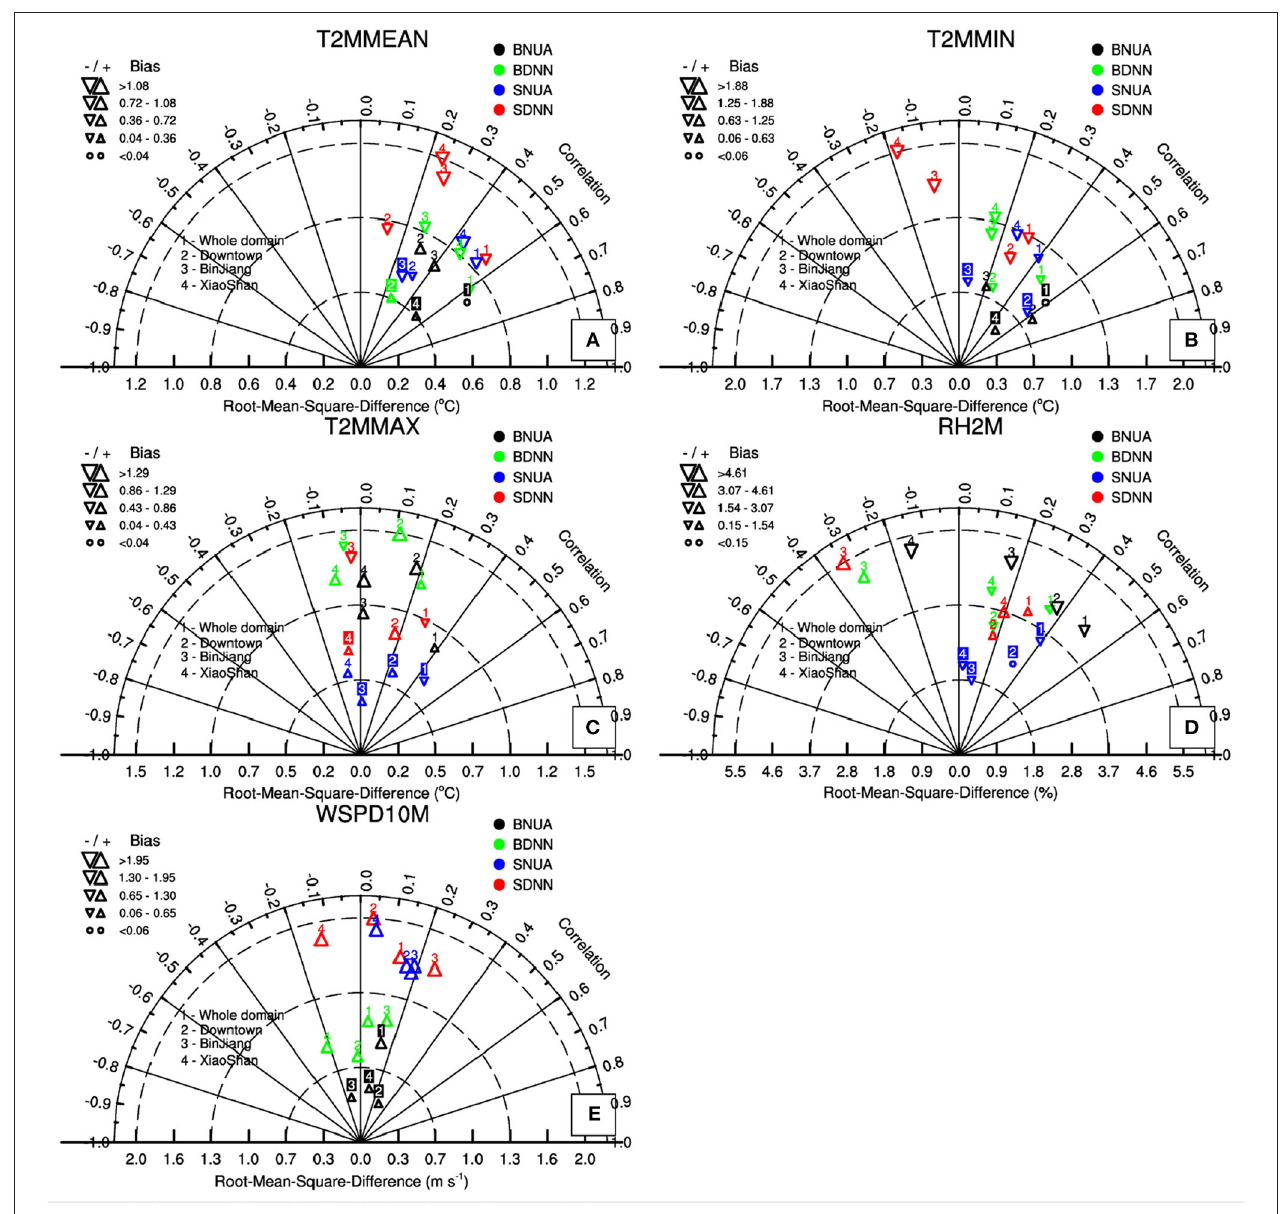
FIGURE 7 | Verifying the WRF forecasts against the AWS observations. The diagrams presenting the bias (size of the triangle, upward/downward refers to positive/negative), the root-mean-square difference (distance from origin) and the spatial correlation coefficient (azimuthal scale) between any forecast and the observations for (A) daily mean temperature at 2m; (B) daily minimum temperature at 2m; (C) daily maximum temperature at 2m; (D) daily mean relative humidity at 2m; (E) daily mean wind speed at